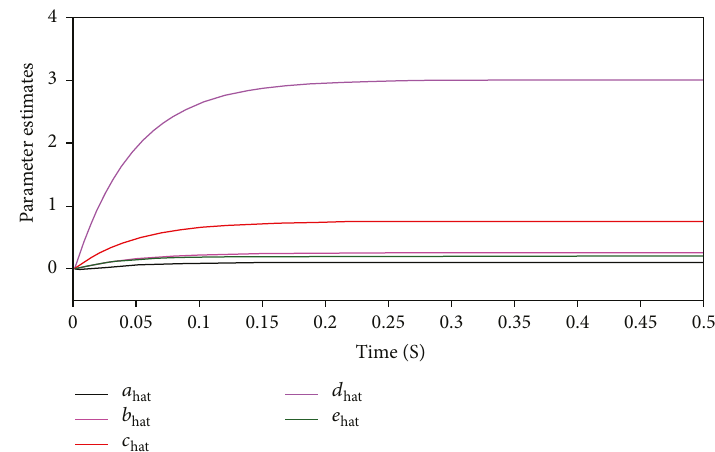
Figure 7: The time history of the parameter estimates of the FOPCC system.